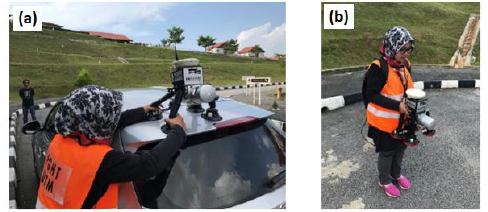
Figure 7. Mobile laser scanning (a) vehicle-based mode and (b) human-based